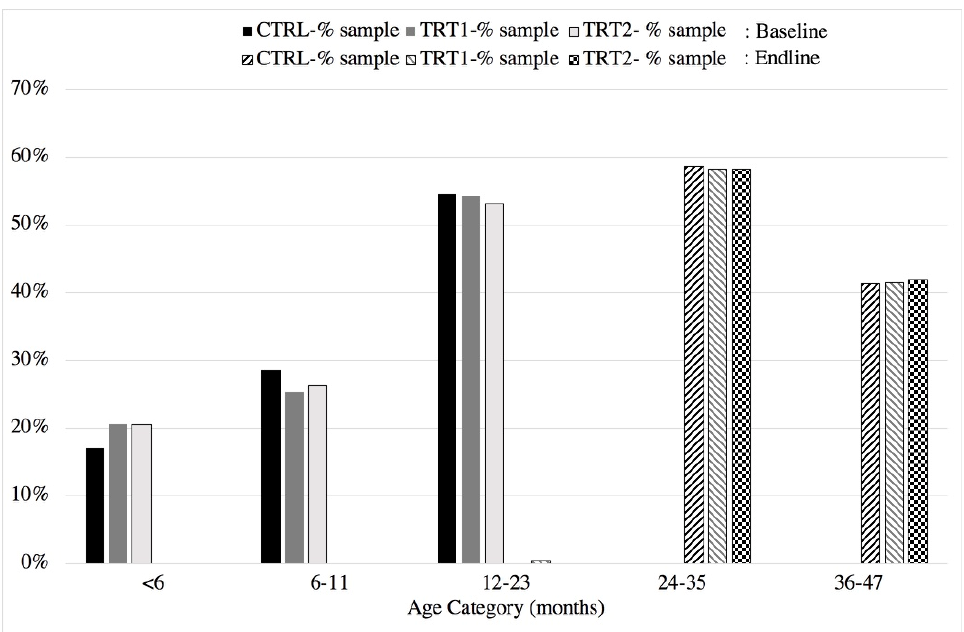
Figure 3. The percentage of the sample in each age category at baseline and end line of the intervention (baseline: 2017; end line: 2018).